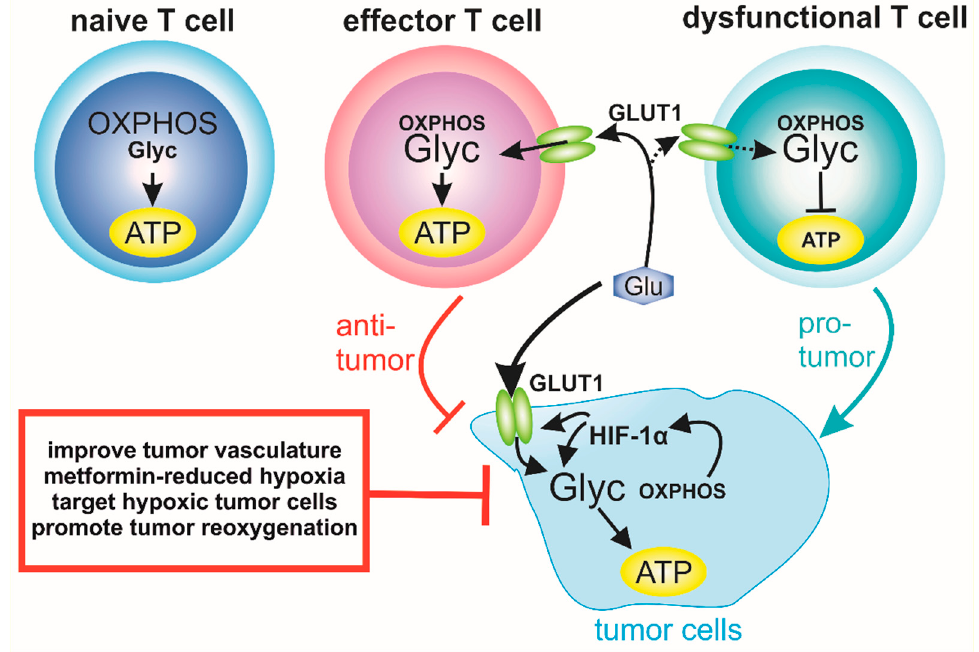
Figure 3. T cell Tumor cell metabolism dictates T cell e ff ector function. Naïve T cells produce ATP predominantly by oxidative phosphorylation. After activation, a metabolic switch towards glycolysis is associated with T cell e ff ector functions. Increased expression of the glucose transporter GLUT1 is essential for ATP production in e ff ector T cells. Due to HIF-1 α stabilization in tumor cells, GLUT1 expression is enhanced, which, in turn, leads to accumulation of glucose in tumor cells used for glycolysis, whereby OXPHOS is reduced. As a consequence, su ffi cient glucose is not available to maintain T cell e ff ector functions and T cells adopt a dysfunctional phenotype due to reduced ATP production. Thus, targeting tumor hypoxia, e.g. by metformin, is a novel strategy to improve T cell function and response to immune-check point